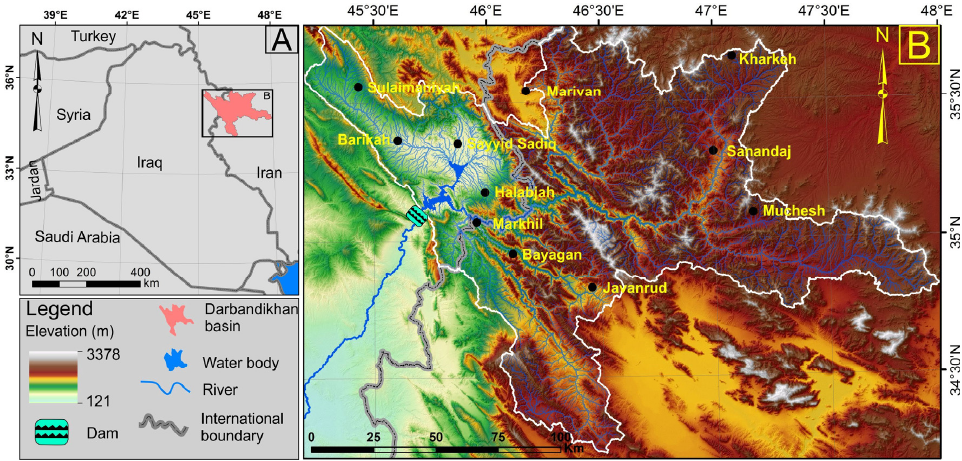
Figure 1. Location map of the Darbandikhan basin.